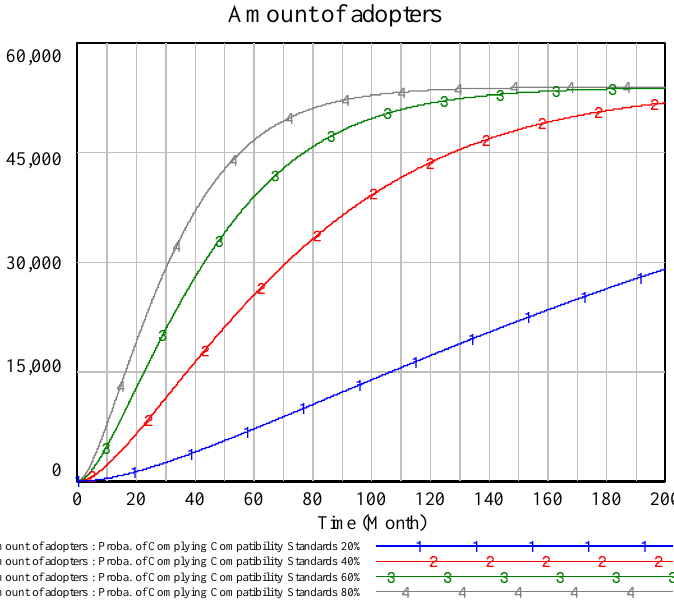
Figure 11. Sensitivity of probability of complying with compatibility standards on number of adopters.